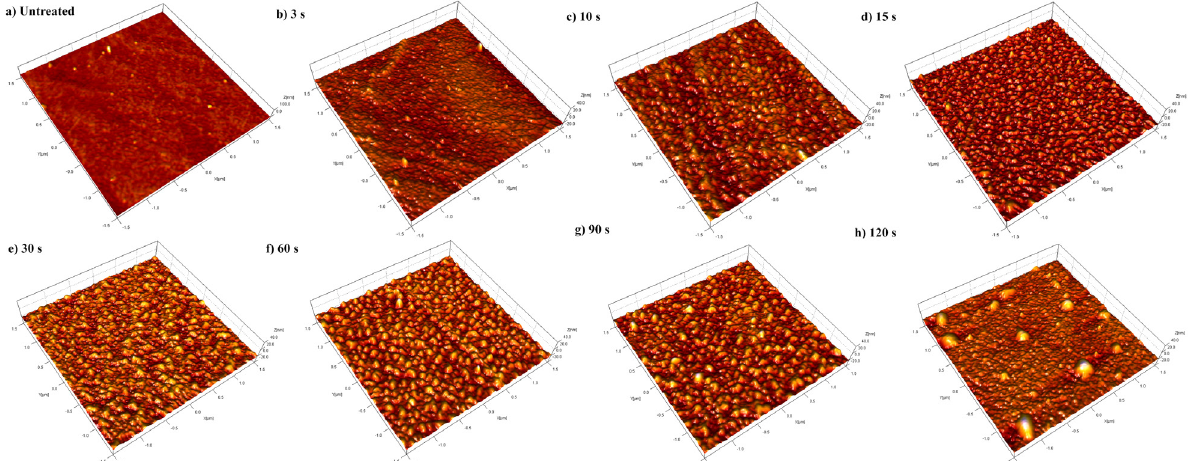
Figure 4 : AFM images of samples treated in plasma.